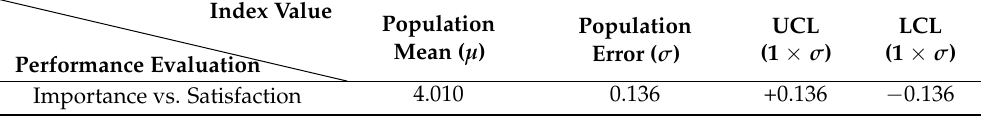
Population UCL LCL Population Mean ( µ ) (1 × σ ) (1 × σ ) Error ( σ )